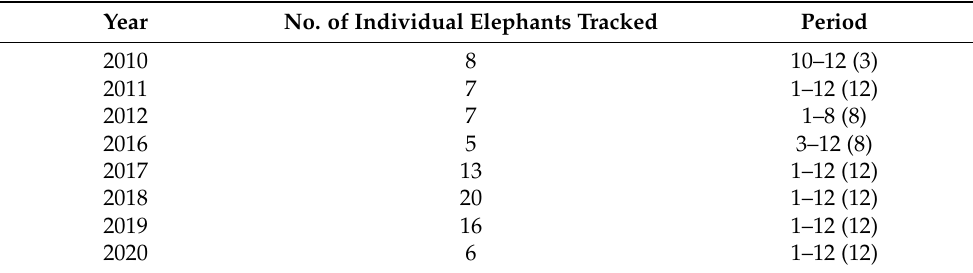
Table 1. The tracked elephant data used in this study. The periods correspond to the 12 calendar months of the year. The total length of tracking period (in months) is shown in brackets. Year No. of Individual Elephants Tracked